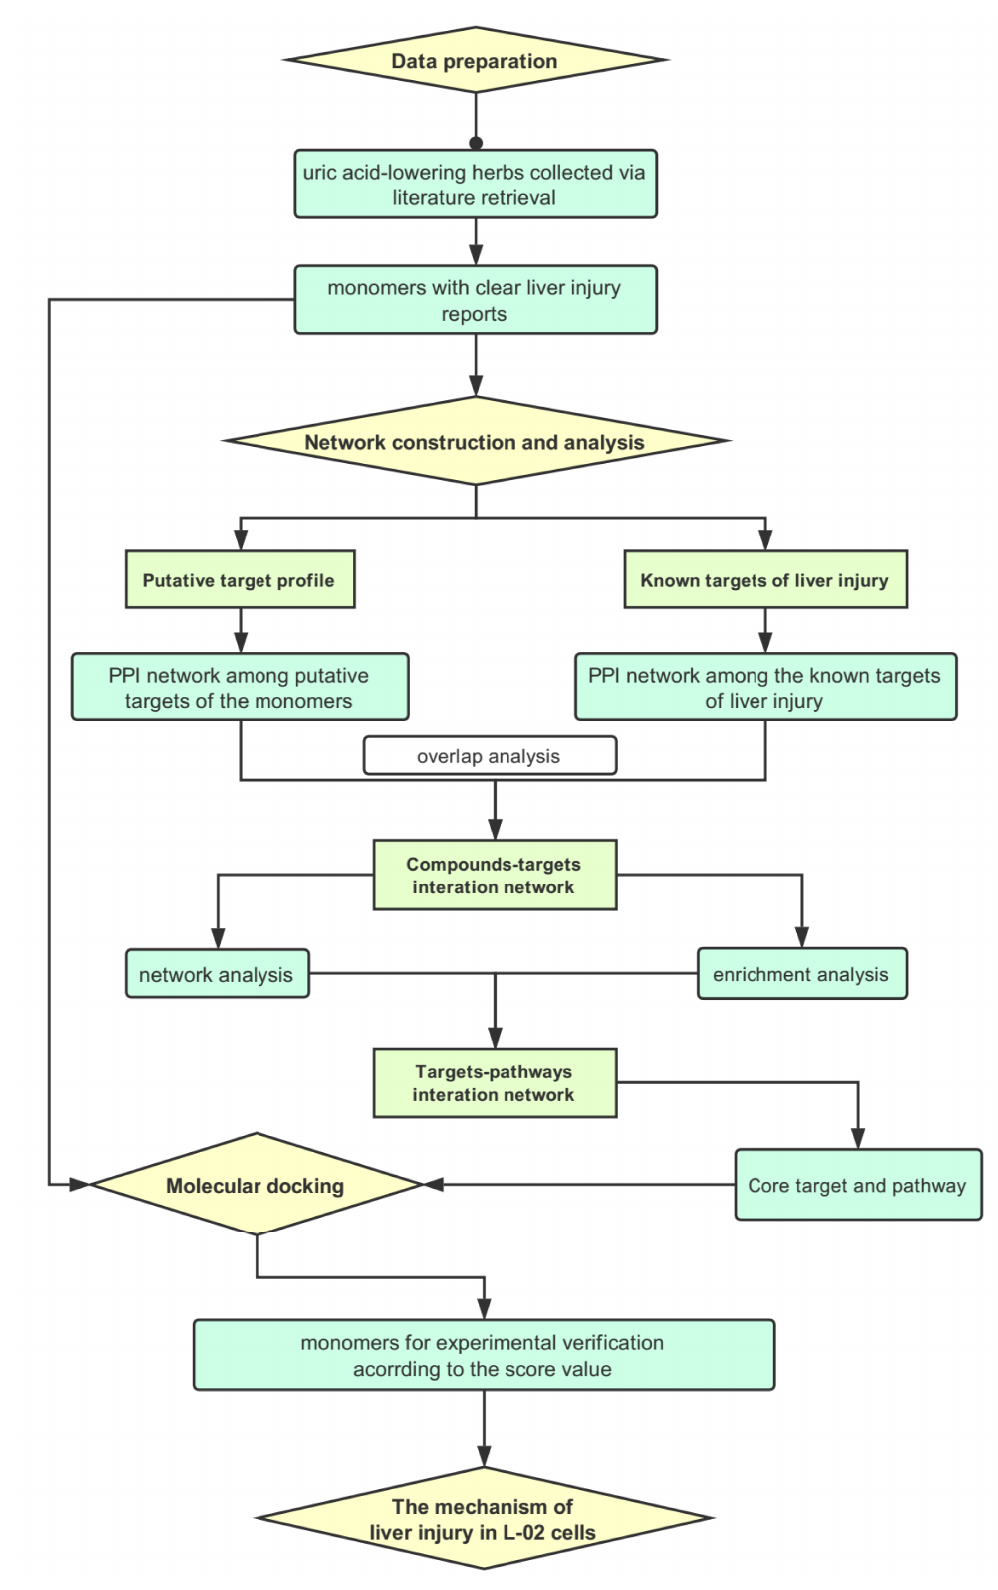
Fig 1. The flowchart of technical strategy in current study.